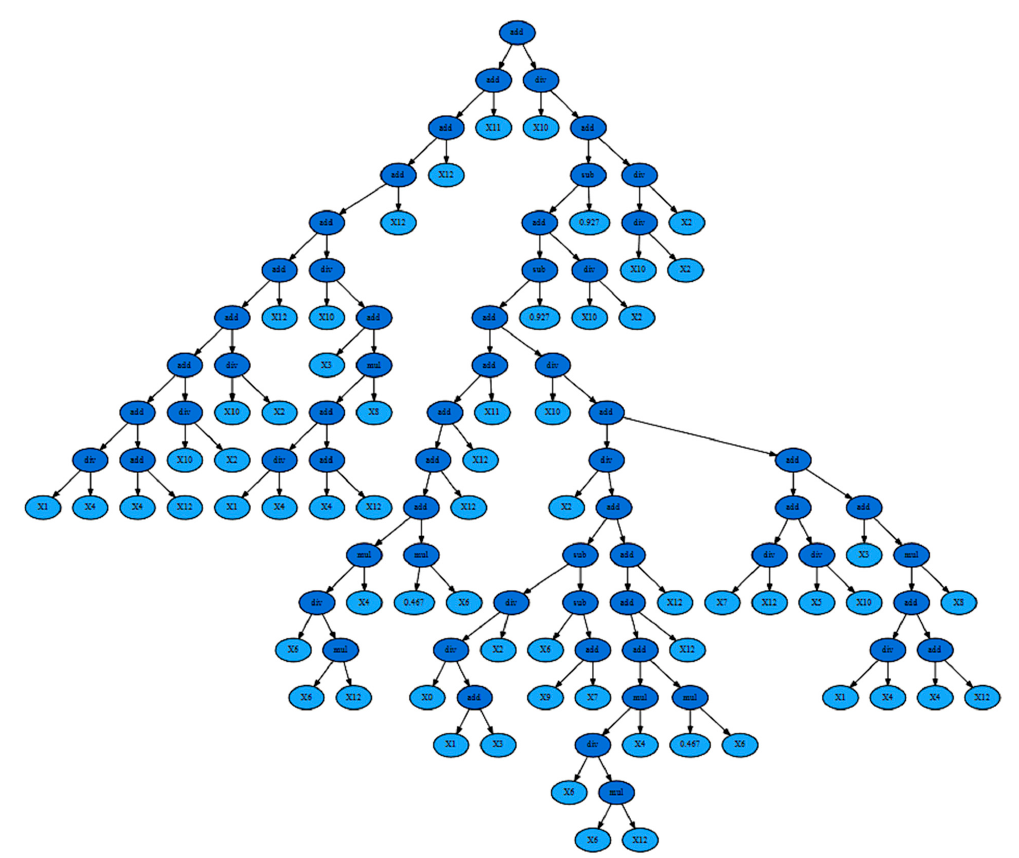
Figure 2. Symbolic Regression tree for age group 1, telomere + arteries experiment (MAE 1.157639). Corresponding expression formula: add(add(add(add(add(add(add(add(add(div(X1, X4), add(X4,